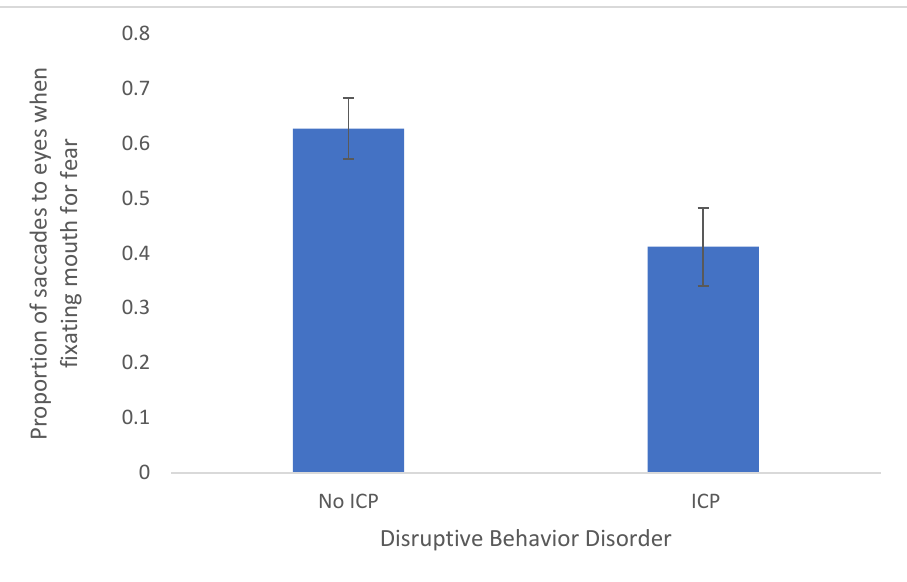
Figure 2. Gaze shifts to the eyes of fearful faces when the mouth was initially fixated by ICP grouping.